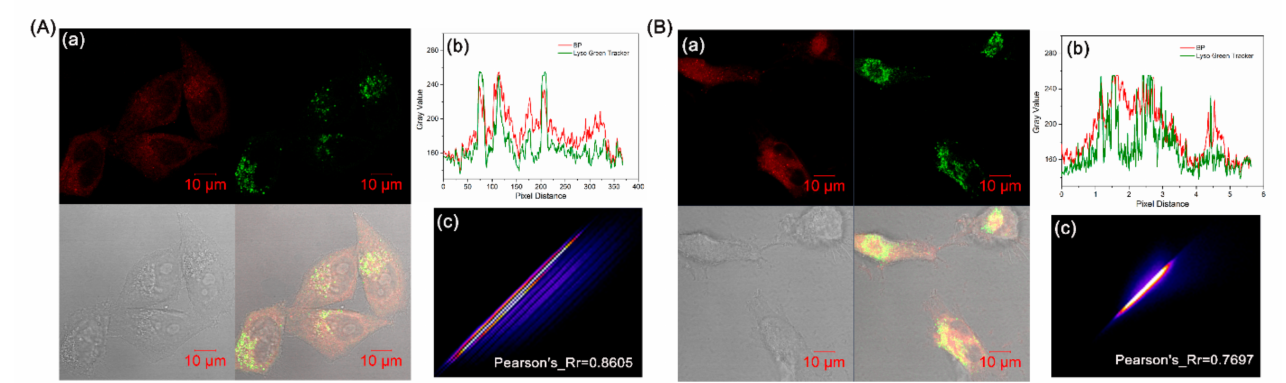
Figure 5. Colocalization experiments of BP and LysoTracker Green DND-26 in HeLa cells ( A ) and U87 cells ( B ). ( a ) Confocal images of cells treated with 10 µ M BP, pH = 7.4. ( b ) Plot profile of BP and LysoTracker Green DND-26. ( c ) Scatter plot of BP and LysoTracker Green DND-26 in cells. Green channel: λ ex = 488 nm, λ em = 490–530 nm; Red channel: λ ex = 561 nm, λ em = 600–750 nm. To better identify the simultaneous colocalization of mitochondria and lysosomes, BP and two organelle-targeting trackers, MitoTracker Green FM ( λ ex = 490 nm and λ em = 513 nm) and LysoTracker Blue ( λ ex = 373 nm and λ em = 422 nm), were simultaneously adopted for further colocalization experiments [54]. U87 cells and HeLa cells were pretreated with 10 µ M BP, subsequently incubated with MitoTracker Green FM and LysoTracker Blue DND- 22. As depicted in Figure 6, BP exhibited strong red fluorescence in U87 and HeLa cells (pH = 7.4). Significantly, the overlay between BP and MitoTracker Green (Figure 6A) dis- played that the green fluorescence had a desirable overlap with red fluorescence, whereas the non-merged parts (white circle) coincided well with blue fluorescence from LysoTracker Blue. Coincidentally, a similar phenomenon was also observed in HeLa cells (Figure 6B). Additionally, the corresponding Pearson’s correlation coefficients were 0.9535 and 0.9069 for mitochondria and lysosomes in U87 cells, while the corresponding Pearson’s correlation coefficients were 0.8965 and 0.8487 for mitochondria and lysosomes in HeLa cells. These results more fully proved the simultaneous colocalization of mitochondria and lysosomes by